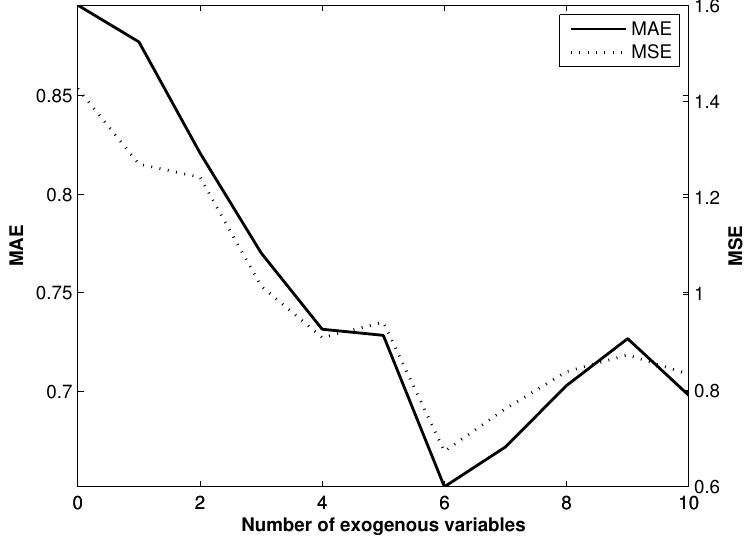
Figure 13. Evolutions of the mean absolute error (NAE) and mean squared error (MSE) errors obtained by the best model in the function of the exogenous variables used.